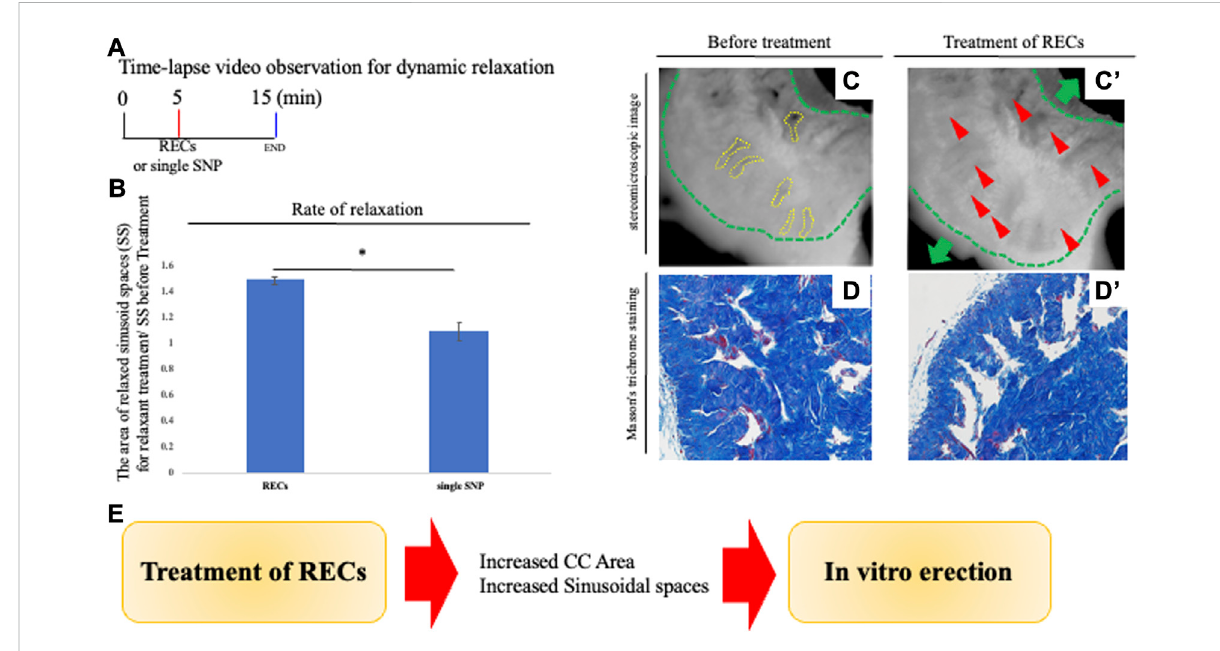
FIGURE 2 Analysis of penile relaxation responses. (A) Time-lapse video observation criteria for dynamic relaxation. In order to analyze the relaxation process invitro ,time-lapsevisualization analysis(theimagesweretaken10 sapart)wasperformed.Forachieving anexplantrelaxationafter5 minof the pre-contraction, relaxation-enhancing compounds (RECs) were applied. After REC treatment, time-lapse pictures were taken for 10 min. RECs ofthe fi nal concentration ofeach reagent weretreated with 100 μ Msodium nitroprusside,1.0 μ Macetylcholine,and 10 μ M prostaglandinE 1 . A time-lapse video analysis was performed by ImageJ software. (B) Graph was calculated from images of the movie and indicates the relative area of sinusoidal spaces by the prominent phase of the movie. The relaxed CC was signi fi cantly increased in its sinusoidal size compared with single SNP treatment. (C,C 9 ) Representative 8-bit images of the PB dye-stained CC during relaxation responses. Many sinusoidal spaces in CC are indicated by yellow dotted lines. From sequential images (interval time was 10 s), the sinusoidal spaces were calculated before and after treatment by ImageJ software. Relaxationwas represented as aratio ofthe area of sinusoids treated by RECs and before treatment. The whole CC (indicated by thegreen dottedlineandarrow)wasextended,aswellasthesinusoidalspace.Theredarrowheadsshowthatthecollagenareawasstretchedbythetreatment of the RECs (see Supplementary Movie S2). Scale bar 100 μ m. (D,D 9 ) Image of Masson ’ s trichrome staining of the CC showing the collagen-rich regions. Sinusoidal spaces are separated by structures including collagen fi bers (blue signal). Similar to the time-lapse images, the sinusoidal spaces were dilated after treatment with RECs, and the collagen area was extended toward the tunica albuginea. Scale bar 50 μ m. (E) Schema shows the reproduction of the ‘ erection state ’ by the current system. The central collagen area near the deep arteries showed little movement while the collagen area extended outward around the adjacent collagen area. Therefore, the relaxation movement was observed to be region-dependent inside the CC. These results suggest that treatment with RECs reproduces the “ erectile state ” of the CC in vitro . All data shown are representative results of at least three independent experiments using adult specimens from different litters (n ≥